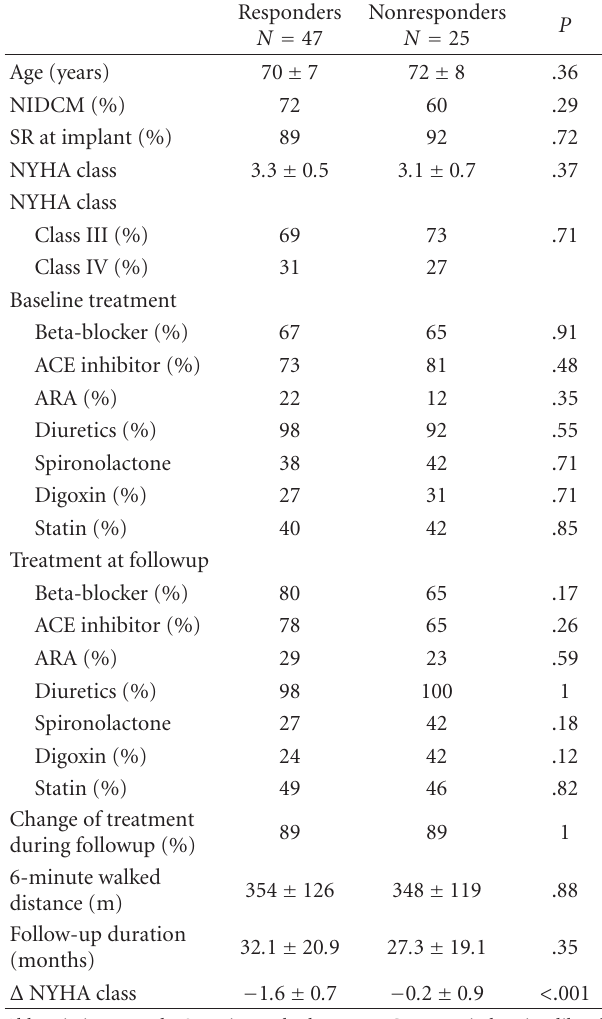
Table 1: Comparison of clinical characteristics in responders and